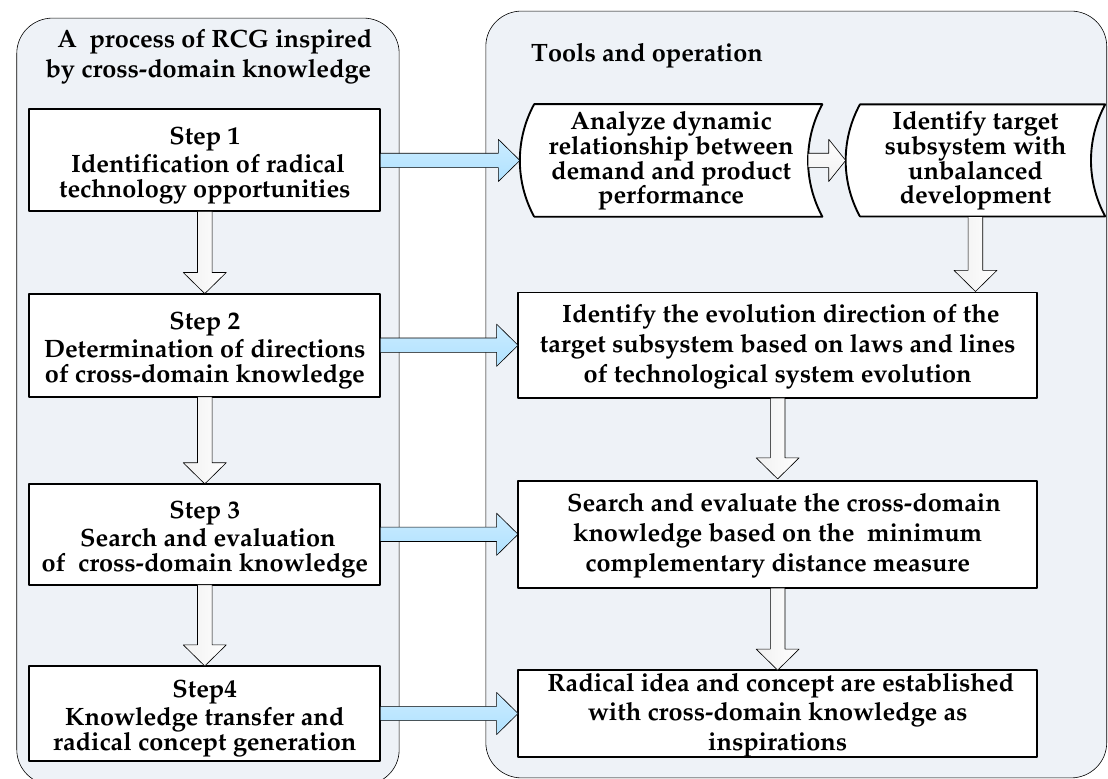
Figure 2. Steps of the proposed approach.